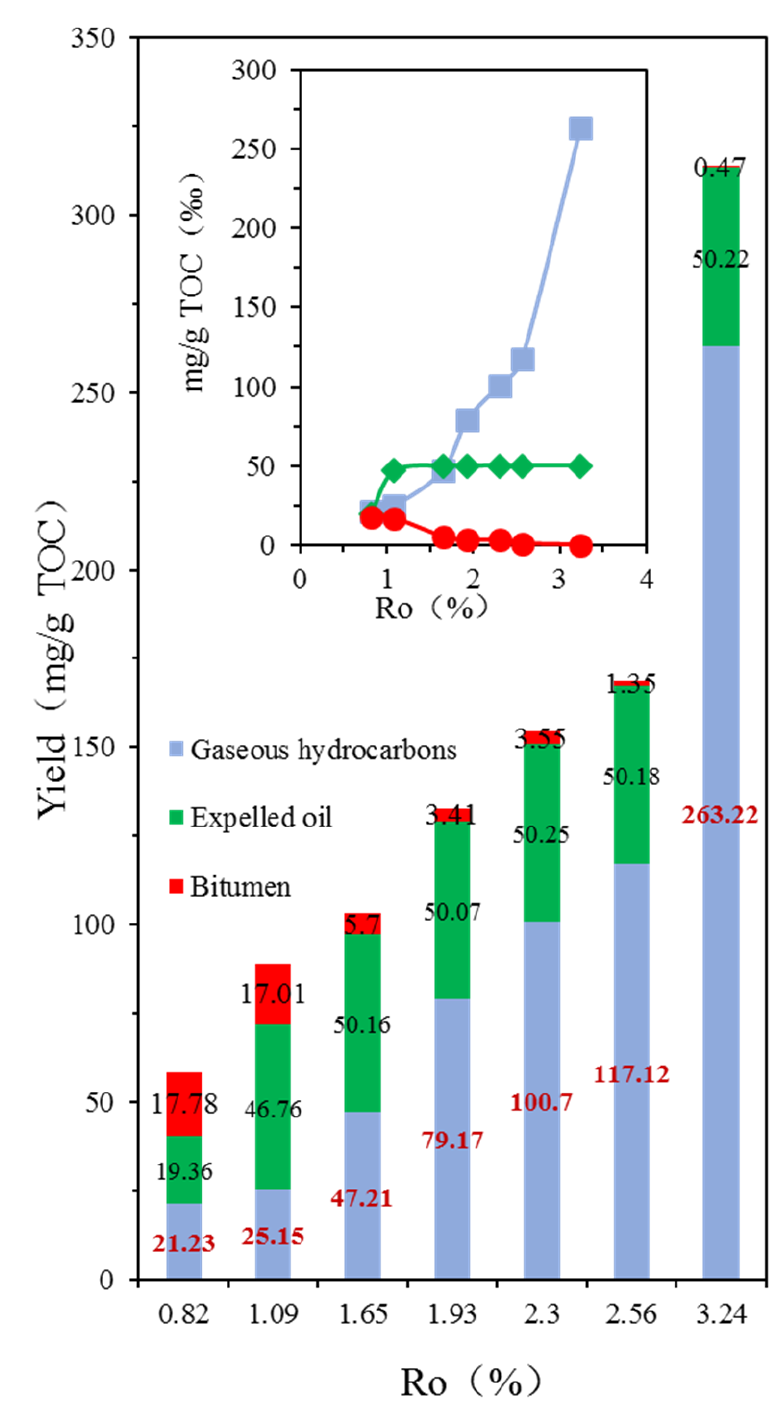
Figure 4. The changing characteristics of gaseous hydrocarbons, expelled oil, and residual bitumen with increasing Ro .